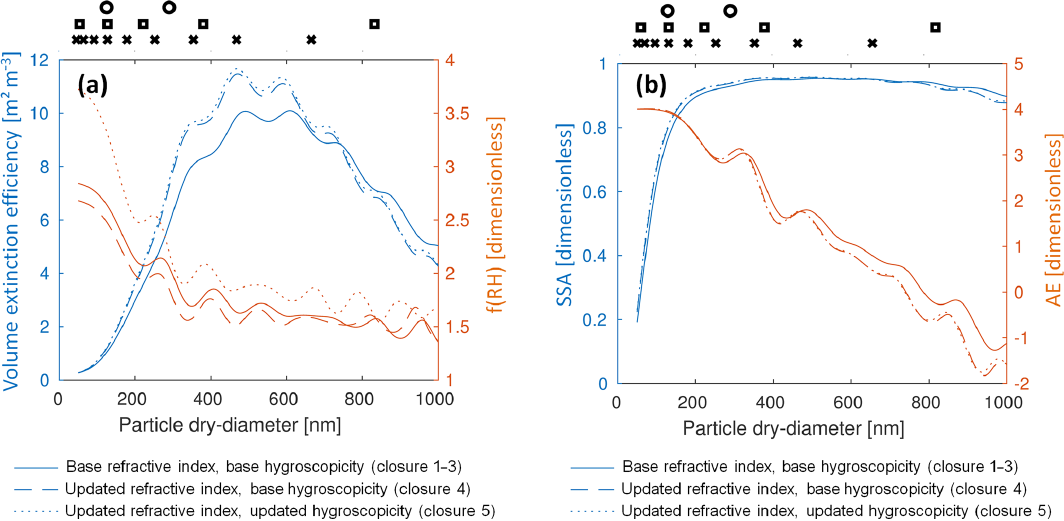
Figure 10. (a) Volume extinction efficiency (blue, scale on the left) and f (RH) (orange, scale on the right) as a function of geometric dry particle diameter considering a monodisperse aerosol distribution of fixed aerosol composition equal to the mean of the data analyzed. Different lines represent cases in which the real refractive index and hygroscopicity correspond to the base and updated conditions (see text for details). Black markers on top of the plots represent the calculated volume mean diameter for each size bin when using 4 (circles), 8 (squares), and 16 (x) bins for the mean observed size distribution (numerical values found in Fig. 8). Note that only mean diameters below 1µm are shown. (b) Same as (a) but for dry single-scattering albedo and the 550–700nm Ångström